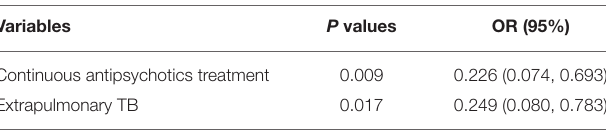
TABLE 2 | Multiple logistic regression analysis of risk factors for retreatment in TB patients with schizophrenia. Variables P values OR